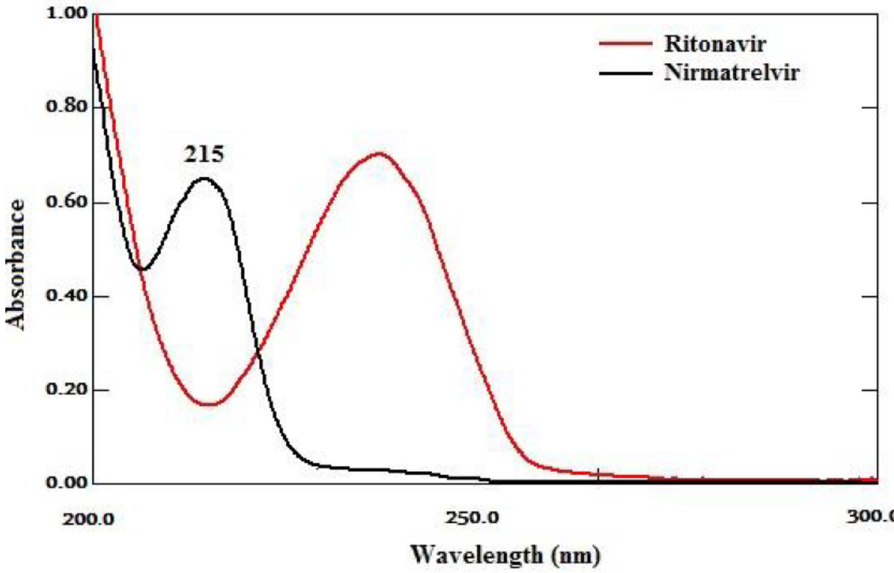
Figure 2. UV spectra of nirmatrelvir (15 μg/mL) and ritonavir (15